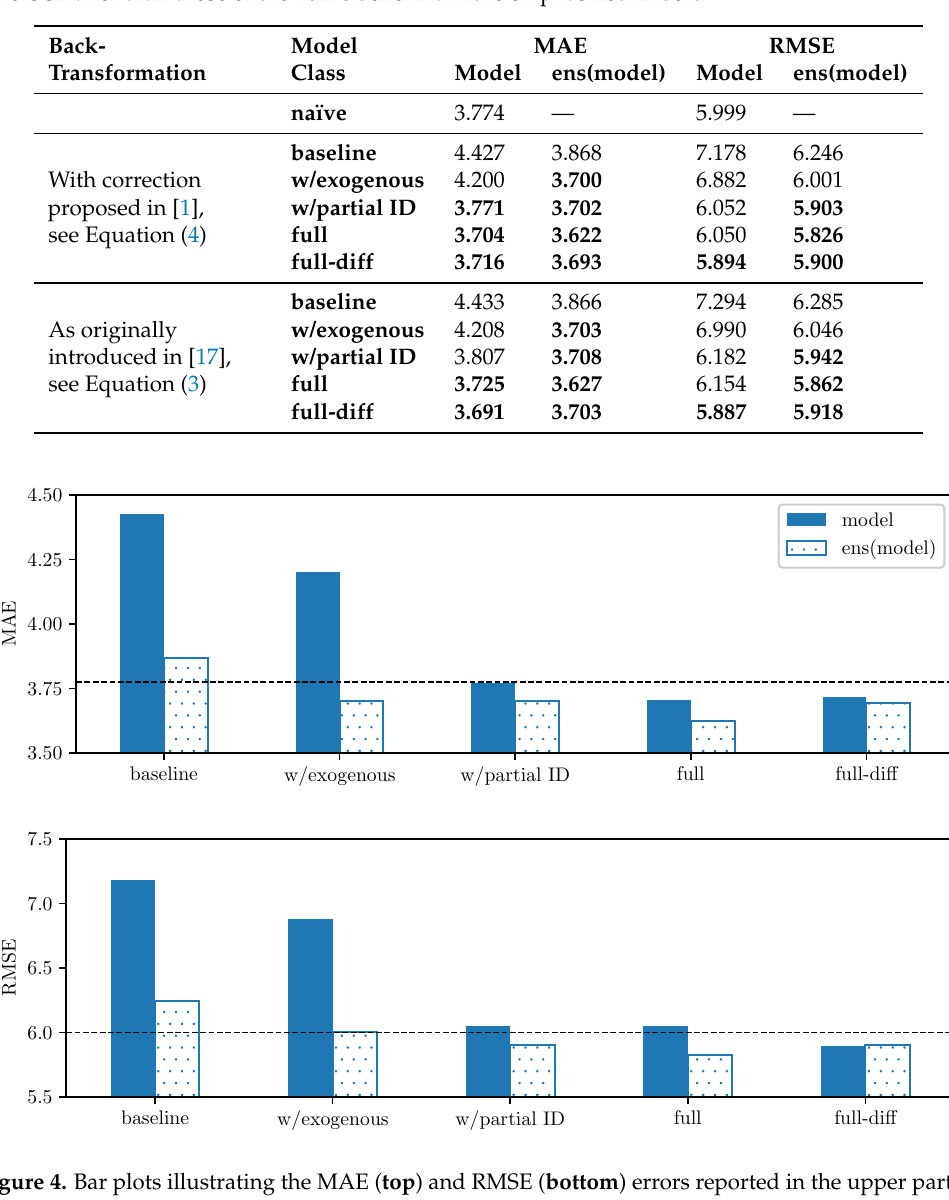
Table 1. MAE and RMSE errors for all 852 days of the out-of-sample test period, see Figure 1. The upper part of the table reports on the results obtained for models which use back-transformation (4), while the lower that use back-transformation (3). Columns labeled ‘model’ refer to the models themselves, while those labeled ‘ens(model)’ to ensembles with the naïve benchmark, as defined in Equation (15). Errors smaller than those of the naïve benchmark are emphasized in bold.